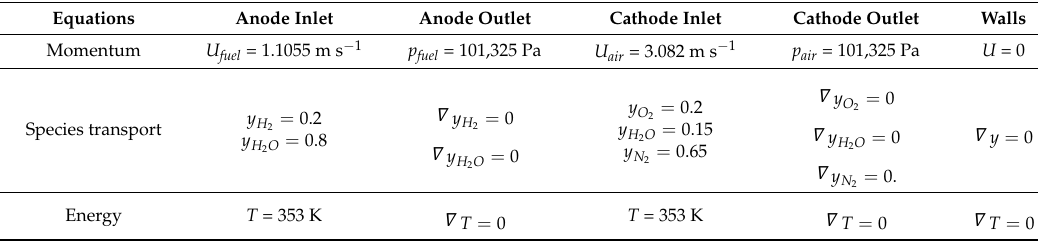
Table 3. Boundary and initial